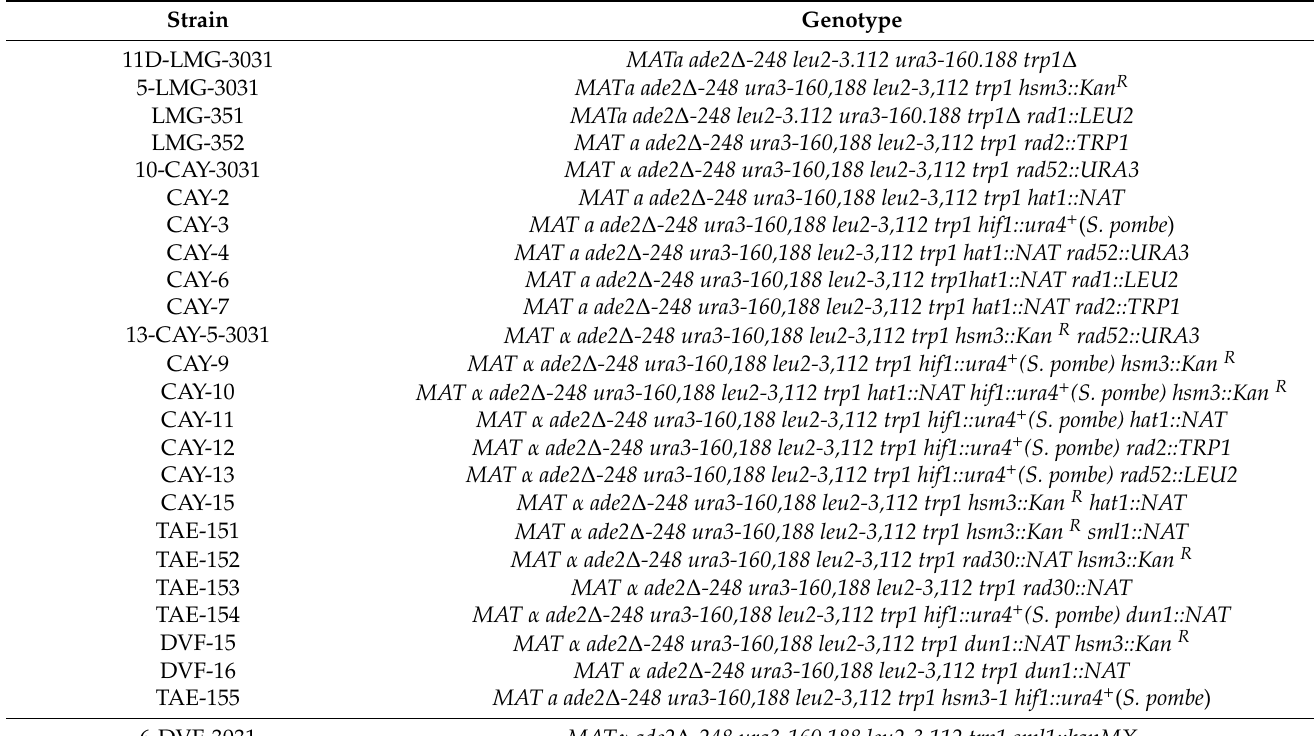
Table 1. Strains’